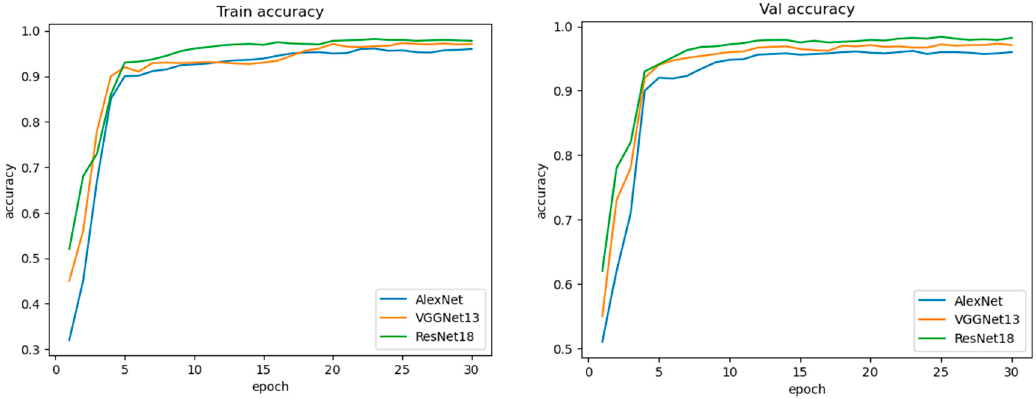
Figure 6. Accuracy curve.